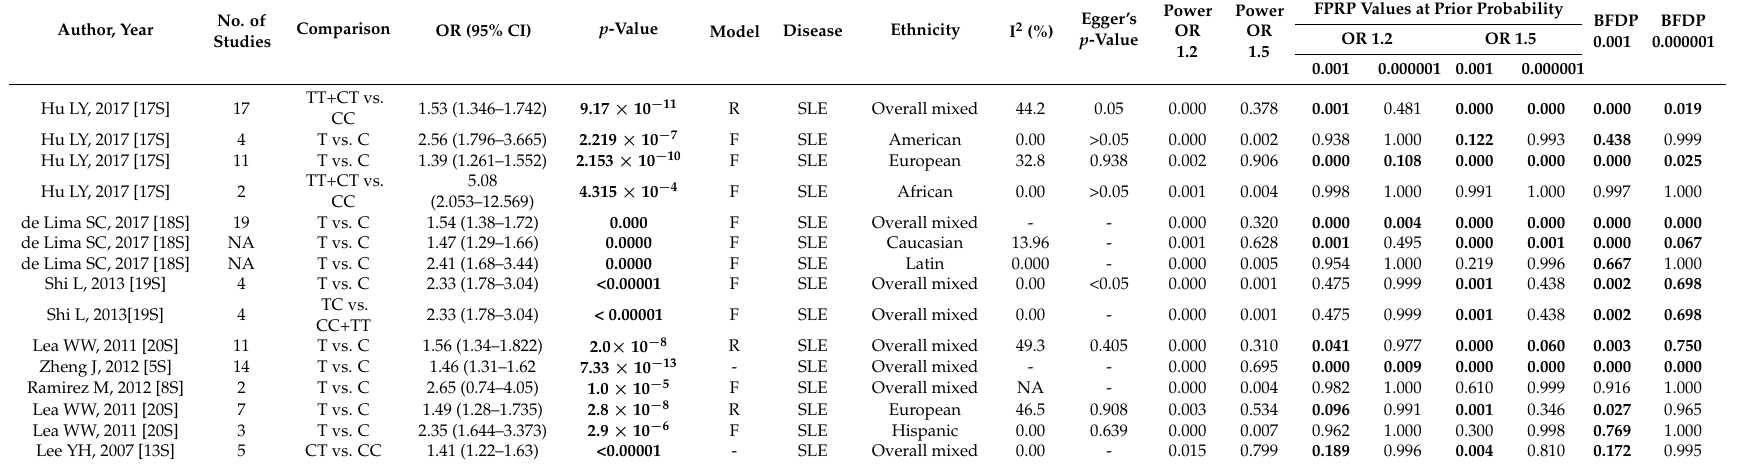
Table 3. Meta-analysis results of associations between systemic lupus erythematosus (SLE) and the PTPN22 1858 C/T polymorphism from observational